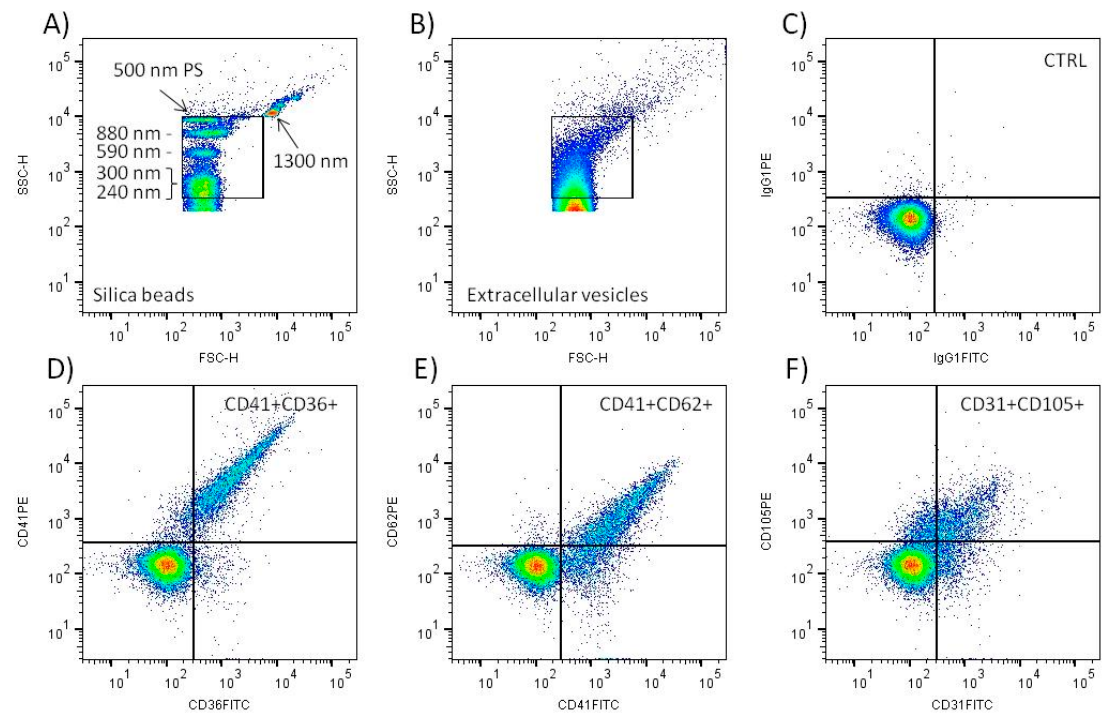
Figure 1. Flow cytometry analysis of large EVs in cord blood plasma. Standard silica and polystyrene (PS) beads were utilized to create EV gate in the SSC-H/FSC-H scattergram ( A ). Typical scattergram signal of cord blood plasma extracellular vesicles ( B ). Only events inside the gate were analyzed. Representative density plot of negative control sample (CTRL) labeled with isotype IgG1 control MAbs ( C ). Representative density plots of samples labeled with CD41 PE + CD36 FITC ( D ), CD41 FITC + CD62 PE ( E ), and CD31 FITC + CD105 PE ( F ) MAbs. Only double fluorescence positive events in the upper right quadrant were included in the analysis.